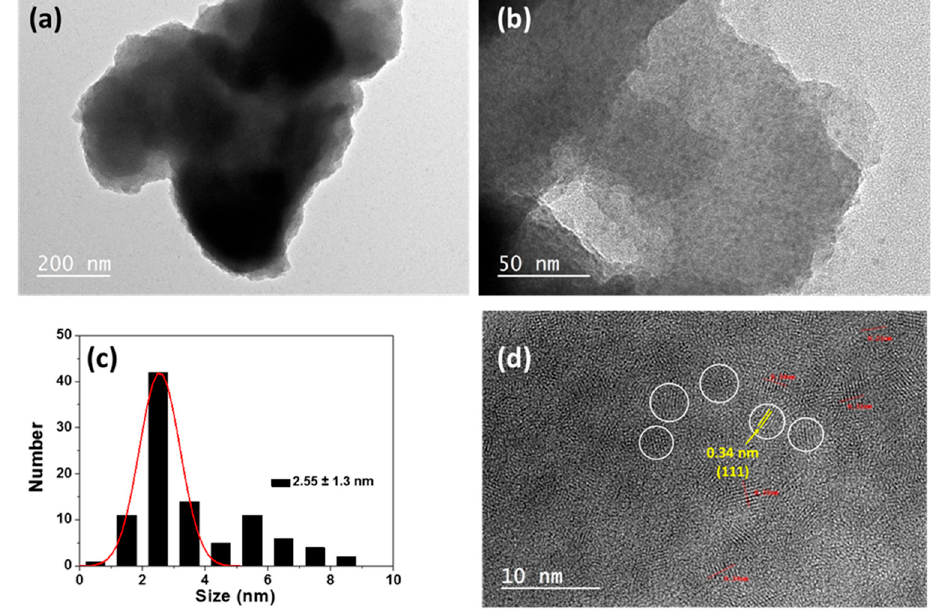
Figure 2. ( a , b ) TEM images of QDs@MIP particles, ( c ) the QDs size distribution and ( d ) HR-TEM images of QDs embedded in the images of QDs embedded in the MIP.